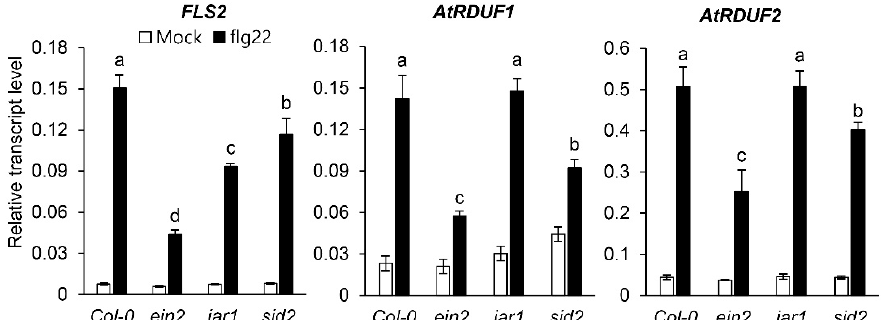
Figure 1. Flg22 induced expression of AtRDUF1 and AtRDUF2 in Arabidopsis mutants. Before performing quantitative reverse transcription polymerase chain reaction (qRT-PCR) analysis, 8-day-old seedlings were treated with 1 µM flg22 or H 2 O for 1 h. Transcript levels of FLS2, AtRDUF1, and AtRDUF2 were measured in wild-type (WT) (Col-0), ein2 , jar1 , and sid2 seedlings, with transcript levels normalized to that of ACT2 . Error bars represent the standard deviation of three replicates. Similar results were obtained in at least two independent experiments. Different letters indicate significant differences among plant genotypes ( α = 0.05, one-way ANOVA and Tukey’s HSD test; JMP 15 software).